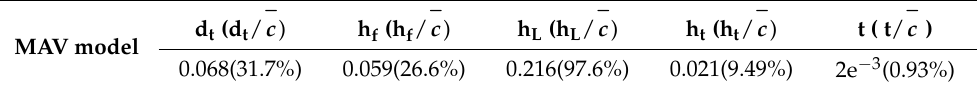
Table 2. Propeller location and fuselage specifications.